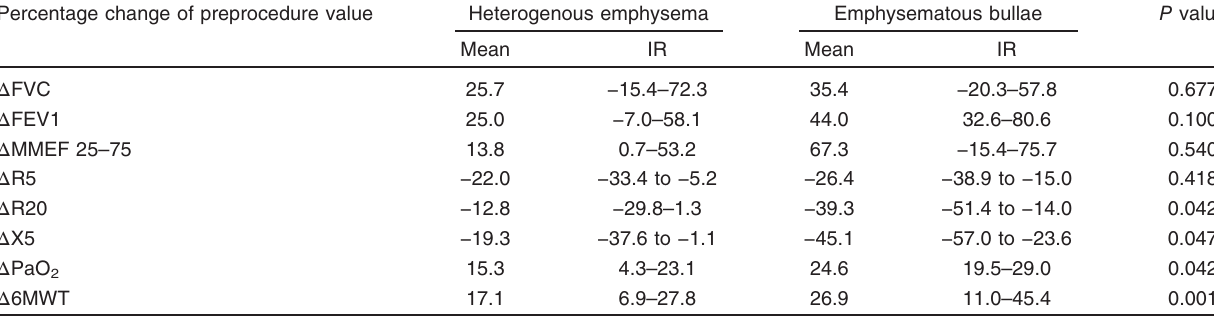
Table 4 Change in outcome measures as percentage of preprocedure value in both groups Percentage change of preprocedure value